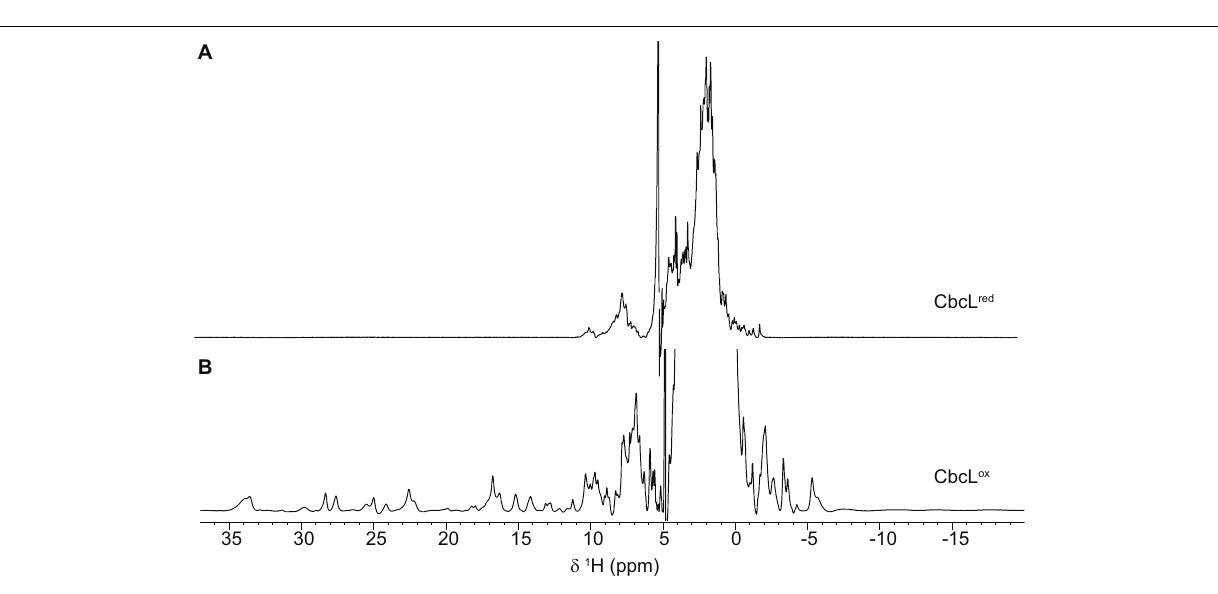
(Jumper et al., 2021) using the ChimeraX software tool (Pettersen et al., 2021) ( Supplementary Figure 2